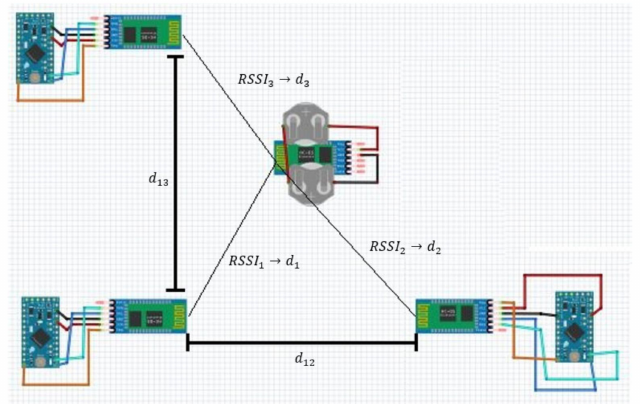
Figure 7. Indoor localization system